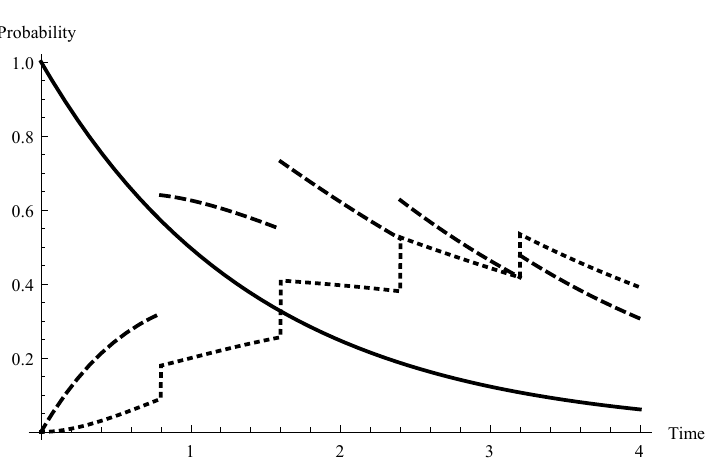
Figure 2. Transient probabilities P { X ( t ) = m , t ∈ I 1 } for λ = 0.7 and for m = 0,1,2.